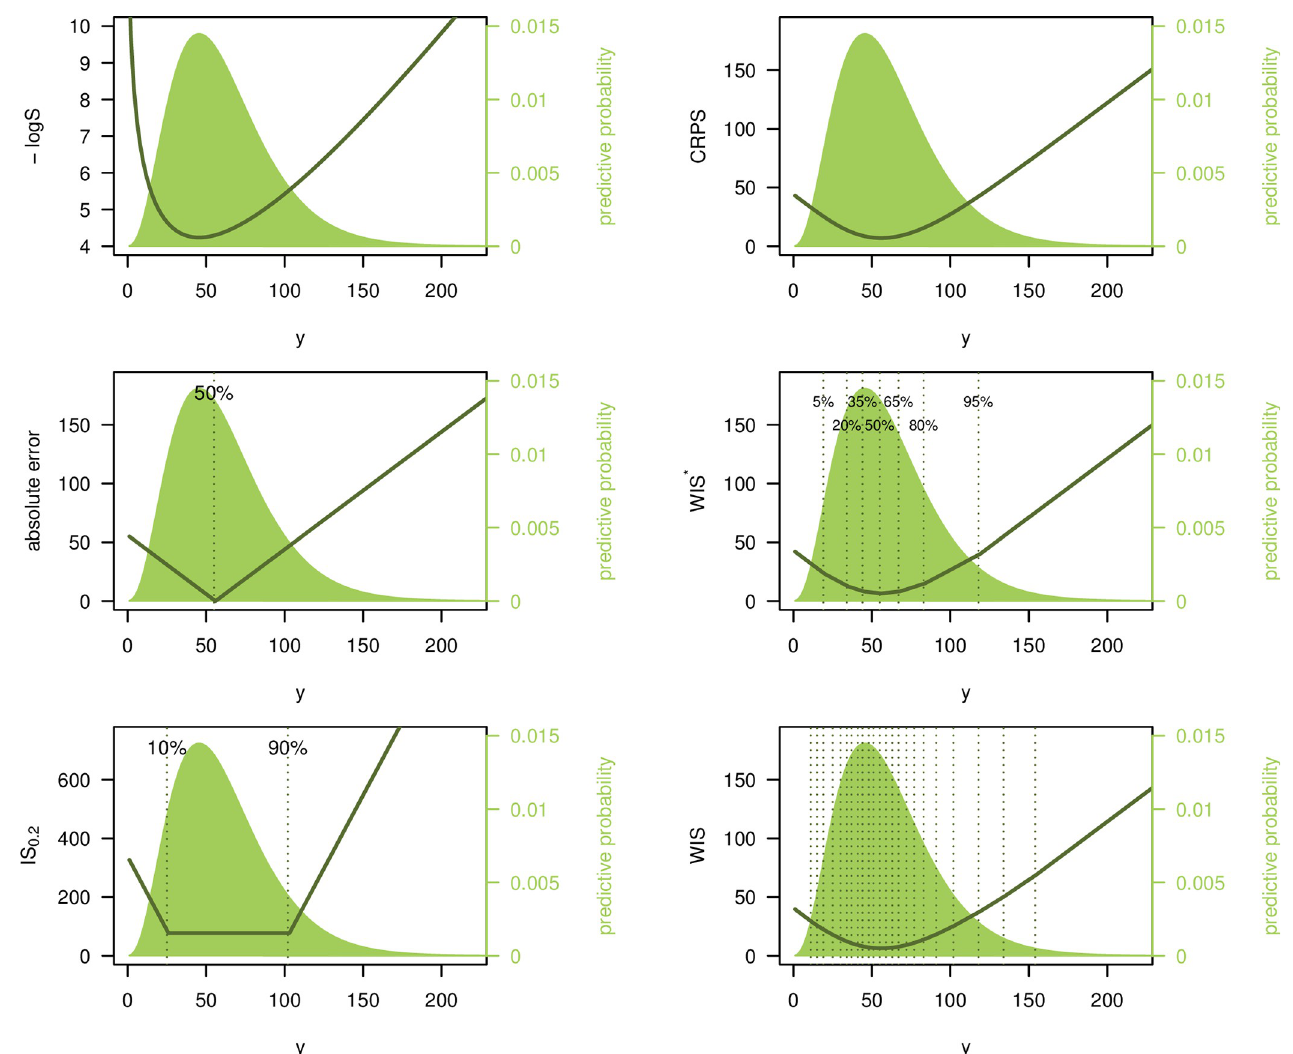
Fig 2. Illustration of different scoring rules. Logarithmic score, absolute error, interval score (with α = 0.2 ), CRPS, and 2 versions of the weighted interval score. These are denoted by WIS � (with K = 3 , α 1 = 0.1, α 2 = 0.4, α 3 = 0.7 ) and WIS ( K = 11, α 1 = 0.02, α 2 = 0.05, α 3 = 0.1, ... , α 11 = 0.9 ). Scores are shown as a function of the observed value y . The predictive distribution F is negative binomial with expectation 60 and size 4. Note that the top left panel shows the negative logS , i.e., − logS , which, like the other scores, is negatively oriented (smaller values are better).